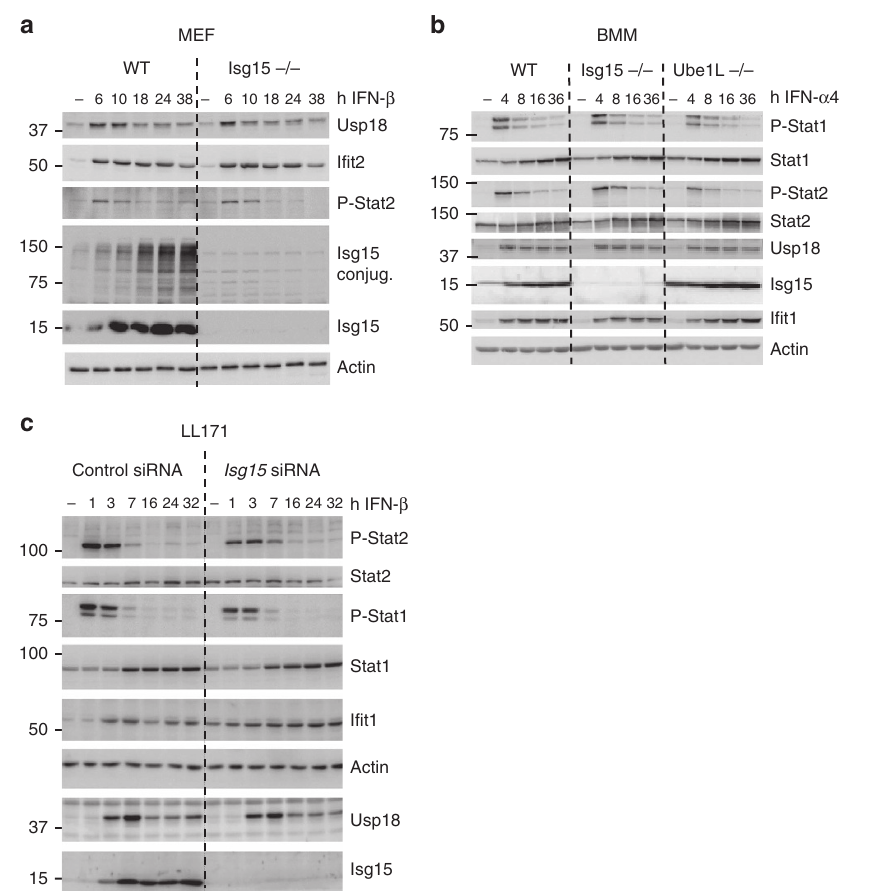
Figure 4 | Murine Isg15 does not control Usp18 accumulation and IFN- a / b signalling. ( a ) Primary MEFs from WTand Isg15 -deficient mice were primed with murine IFN- b (500 pM) for 6–38h. Cell lysates (30 m g) were analysed by western blotting with the antibodies indicated. ( b ) BMM from WT, Isg15 -deficient and Ube1L -deficient mice were primed with murine IFN- a 4 (250 pM) for 4–36h. Cell lysates (20 m g) were analysed by western blotting with the antibodies indicated. ( c ) Murine LL171 cells were transfected with non-silencing control or ISG15 siRNA. 24h post-transfection, the cells were primed for 1–32h with murine IFN- b (10pM). Cell lysates (30 m g) were analysed by western blotting with the antibodies